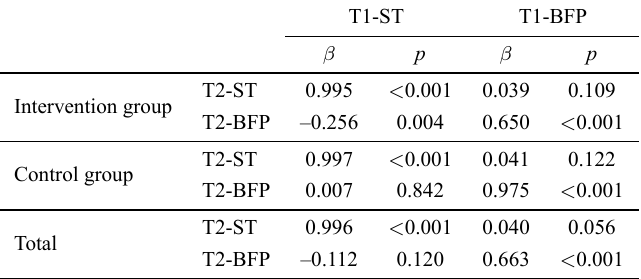
Table 5. Cross-lagged panel analysis